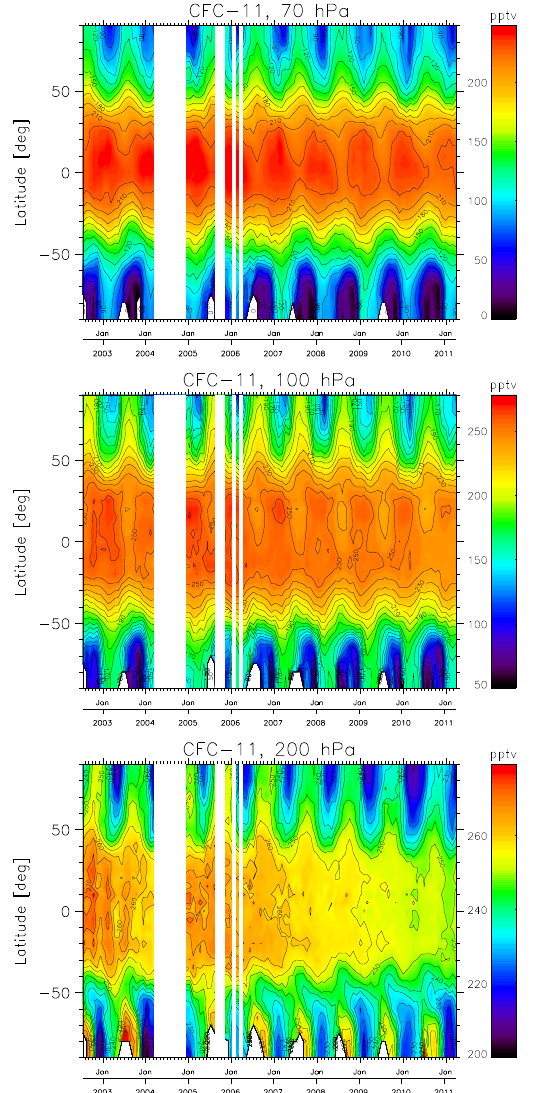
Fig. 6. Timeseries of CFC-11as afunction of latitudebetween July Fig. 7. Time series of CFC-11 as a function of latitude between July 2002 and April 2011 in 15 hPa, 20 hPa and 50 hPa. Note there is Fig.7. Timeseries of CFC-11as afunction of latitudebetween July 2002 and April 2011 in 70hPa, 100hPa and 200hPa. The increased no MIPAS data available between April and December 2004. The 2002 andApril2011 in70 hPa,100 hPaand200 hPa. Theincreased white spots in the southern polar region indicate data gaps due to CFC values in the southern polar regions at 200 hPa are not reliable CFC values in the southern polar regions at 200hPa are not reliable the existence of not detected polar stratospheric clouds, because no and indicate not detected clouds. and indicate not detected clouds. retrievals are possible below cloud top altitude.